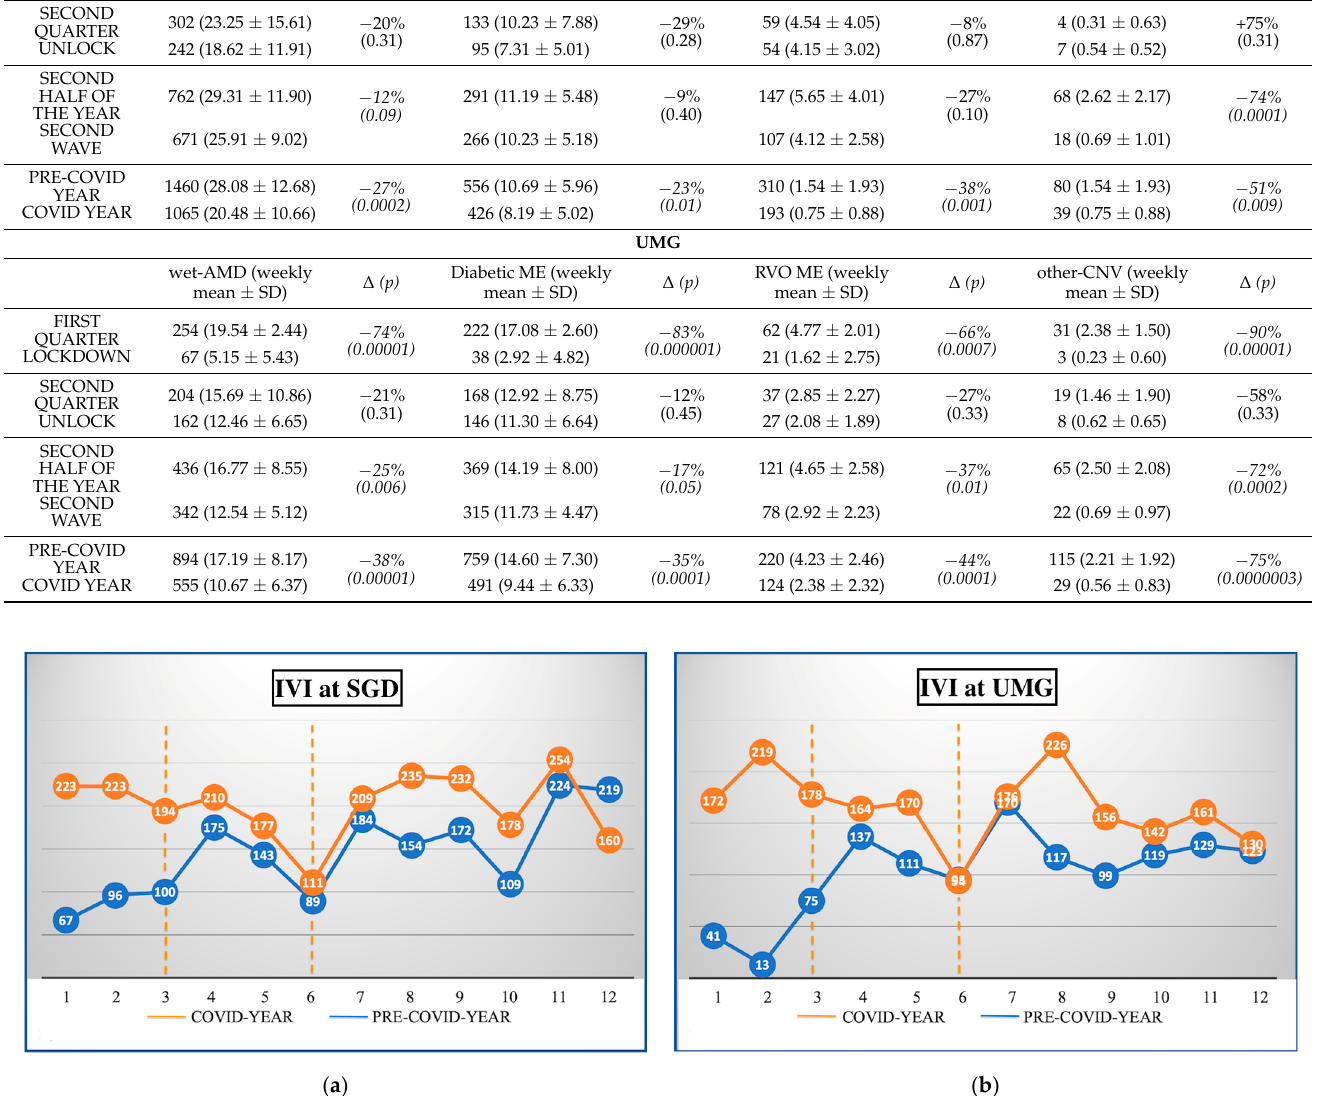
Figure 1. The monthly number of intravitreal injections (IVIs) performed during the COVID year (blue) compared to pre-COVID year (orange) at San Giovanni di Dio (SGD) ( a ) and University Magna Græcia of Catanzaro (UMG) ( b ). The dotted orange line in each figure divided the period studied into three phases: lockdown, unlock, and second wave from left to right,